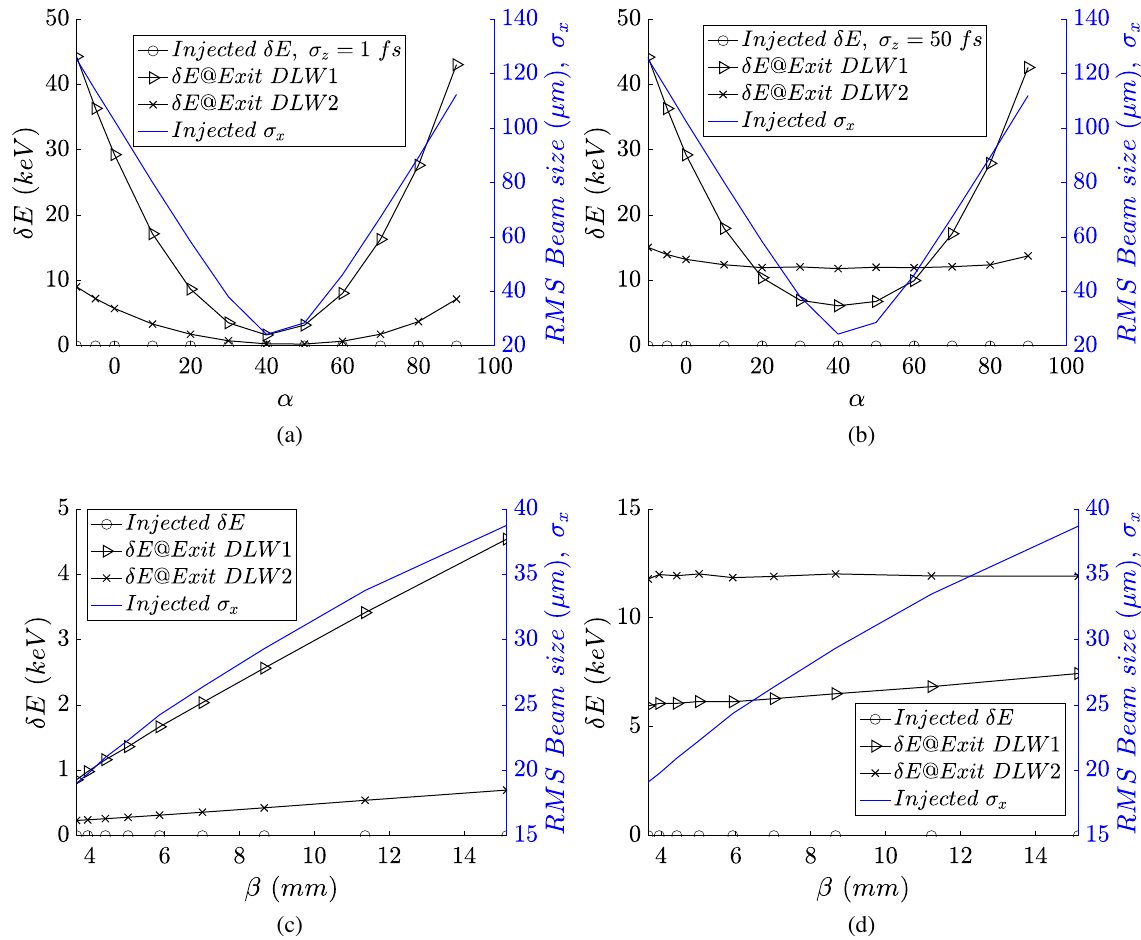
FIG. 13. Evolution of energy spread as a function of (a) and (b) focusing hence α , and (c) and (d) β for an initial emittance of 0.1 mm mrad and 400 keV energy gain per DLW. The vertical columns (a) and (c) present results for rms bunch lengths of 1 and 50 fs, respectively (reading left to right for the bunch lengths). The results are generated under the optimized physical matching matrix described in Sec. III